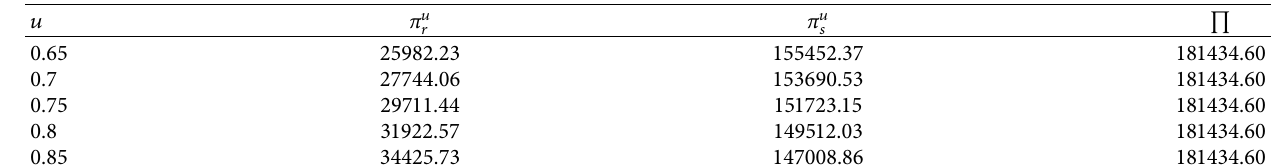
Table 9: Coordination analysis.